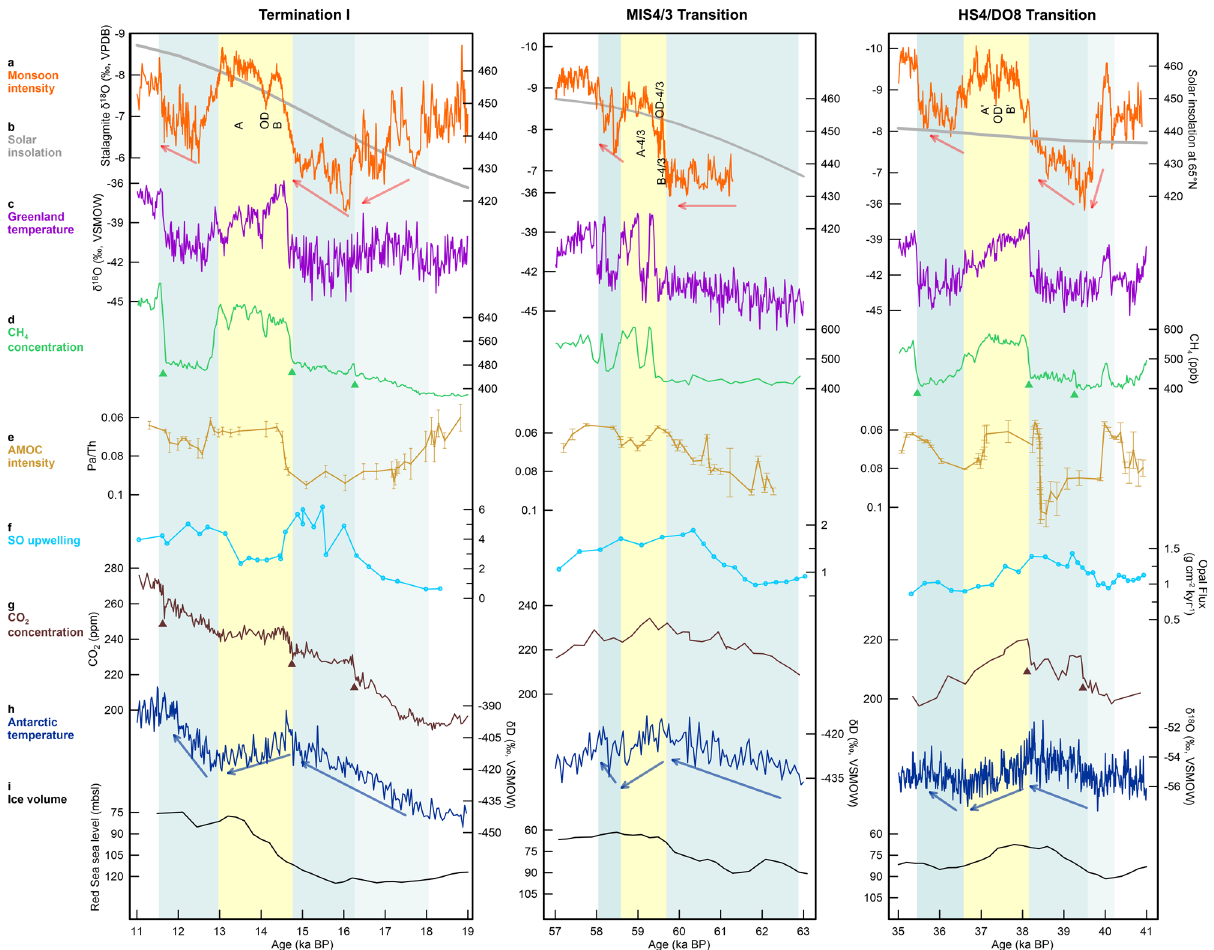
Fig. 4 Geological records across T1, the MIS4/3 transition and the HS4/DO8 transition. From top to bottom are: a Chinese stalagmite δ 18 O calcite records 27,29 and this study (orange), b solar insolation at 65°N (grey) 56 , c NGRIP δ 18 O ice record (purple) 1 , d atmospheric CH 4 concentrations from WDC ice core (green) 5,16 , e Pa/Th record from the North Atlantic (gold) 62,88 , f Opal record from Southern Ocean (blue) 63 , g atmospheric CO 2 concentrations from ice cores in Antarctica (brown) 16,73,74 , h Antarctic temperature record from EDC ice core (blue) 7,87 and i Northern Red Sea sea level record (black) 89 . Periods of millennial climatic events are denoted by colored bars. Three episodes of Bølling (B), Old Dryas (OD) and Allerød (A) within the Bølling – Allerød period are marked, and corresponding periods are coded for the MIS4/3t (middle panel) and the HS4/DO8t (right panel). Colored triangles mark centennial-scale abrupt jumps in CO 2 and CH 4 . Arrows below ( a ) and ( h ) indicate changing trends of the EASM and the Antarctic temperature. The timing and duration of HS1, 4 and 6 are from ref. 90 and references therein. HS1 and HS4 include two bars, indicating periods of initial meltwater pre-events from the European ice sheet (light gray bar, early HSs) and fi nal NH ice sheet collapse (gray bar, late HSs), respectively 66,67